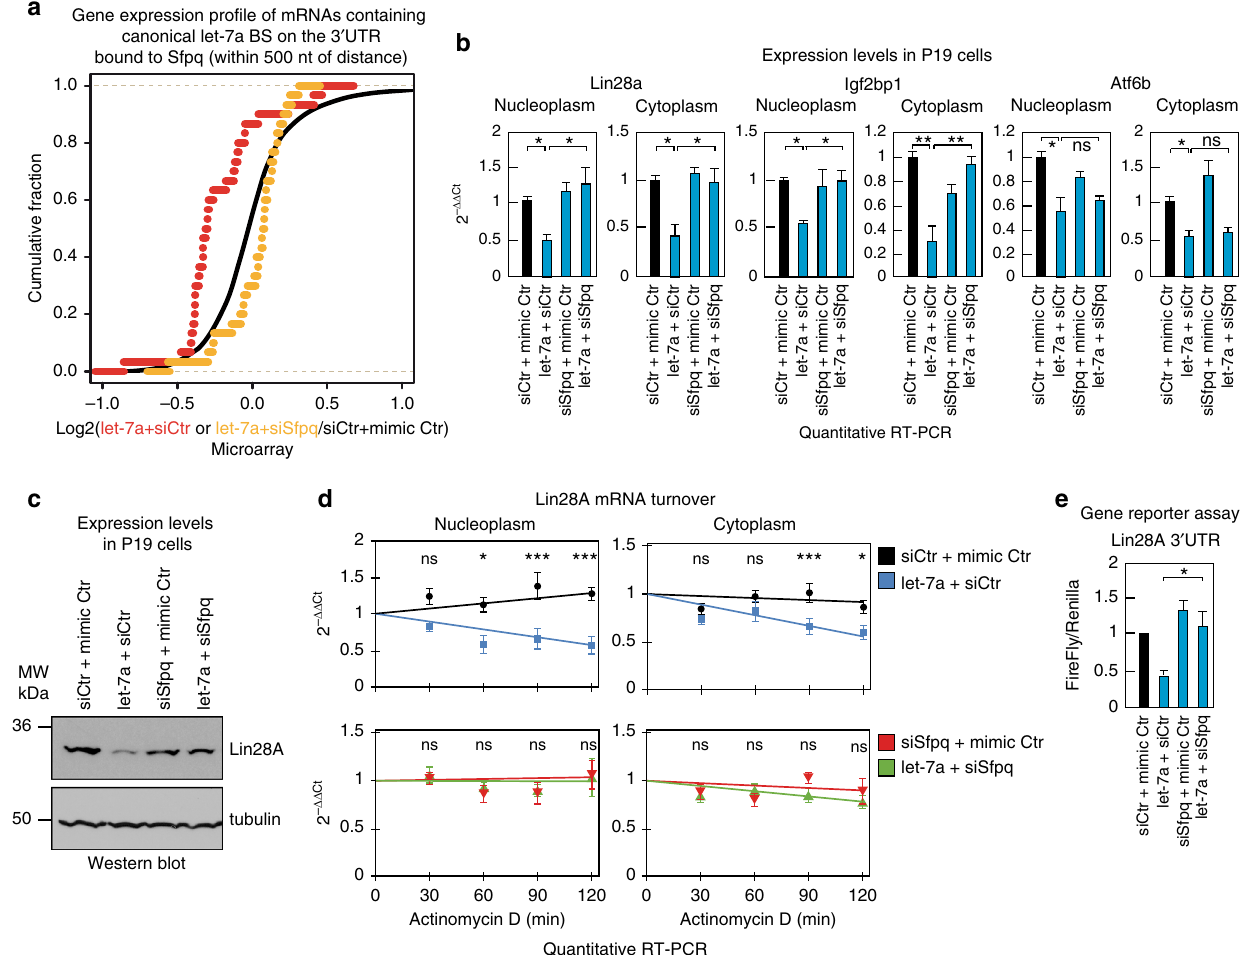
Fig. 5 Sfpq promotes post-transcriptional silencing mediated by miRNAs in both nucleoplasm and cytoplasm. a Gene expression differences in let-7a- transfected P19 cells upon Sfpq knockdown and control. Differential expression is plotted for mRNAs containing canonical let-7a-binding sites (BS) localized in the 3 ′ UTR within a close distance to Sfpq peaks ( < 500 nt) and reduced upon Sfpq knockdown. b P19 cells were transfected with the indicated molecules. Nucleoplasm and cytoplasm were separated to measure the expression levels of the indicated let-7a-target mRNAs. RNA was puri fi ed and analyzed by RT-qPCR. Data are normalized with U2 snRNA and presented as the mean ± s.e.m. ( n = 3). c Immunoblot analysis of Lin28A and tubulin in P19 cells transfected with let-7a and/or siSfpq. d Quantitative RT-PCR analysis of the half-life of Lin28A transcript in let-7a-transfected P19 cells compared to control (upper panels) or siSfpq + let-7a-transfected cells compared to siSfpq control (lower panels). Total RNA from either nucleoplasm (left panels) or cytoplasm (right panels) was isolated at the indicated times after addition of actinomycin D. Data are normalized with β 2-microglobulin and presented as the mean ± s.e.m. ( n = 6). e Relative luciferase activity of reporter constructs containing the mouse Lin28A 3 ′ UTR sequence in HEK293T cells transfected with let-7a and siSfpq as indicated. The data were normalized using Renilla activity and presented as the mean ± s.e.m. ( n = 4). One-way ANOVA followed by Tukey ’ s post hoc test: * p < 0.05, ** p < 0.01, ns not signi fi